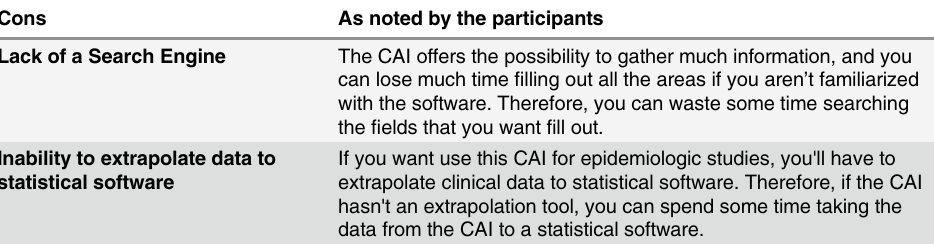
Table 5. Cons of the CAI in relation to other nutrition software.